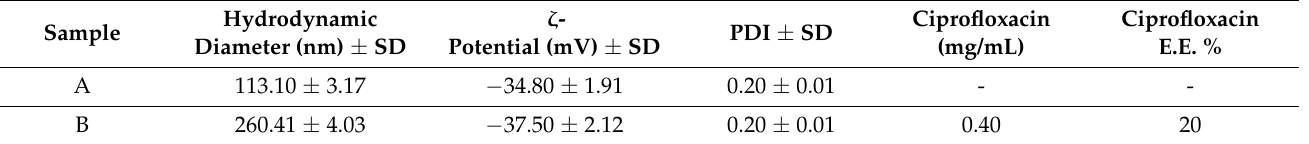
Table 3. Niosomal formulations characterization: summary of physicochemical features.